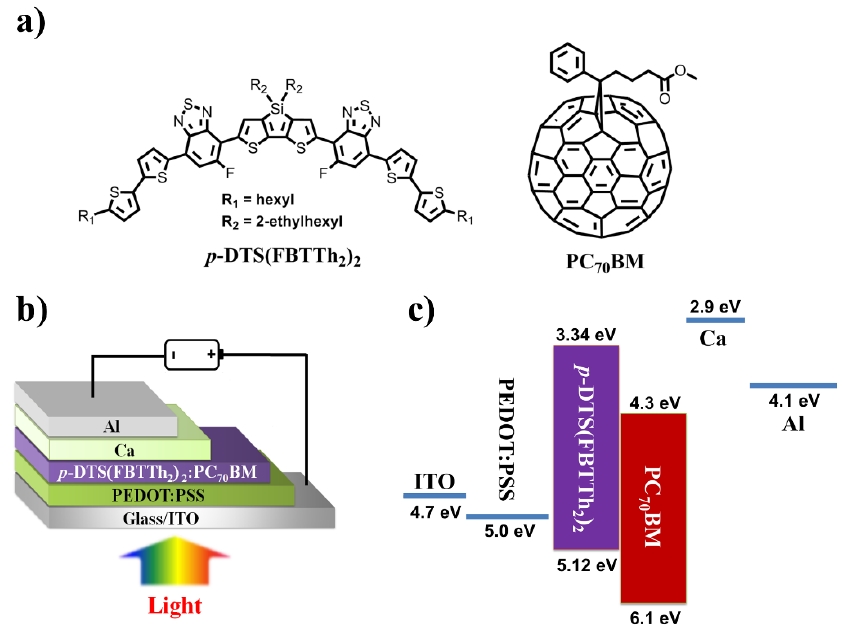
Figure 1. ( a ) Chemical structures of p -DTS(FBTTh 2 ) 2 and PC 70 BM; ( b ) device architecture for small-